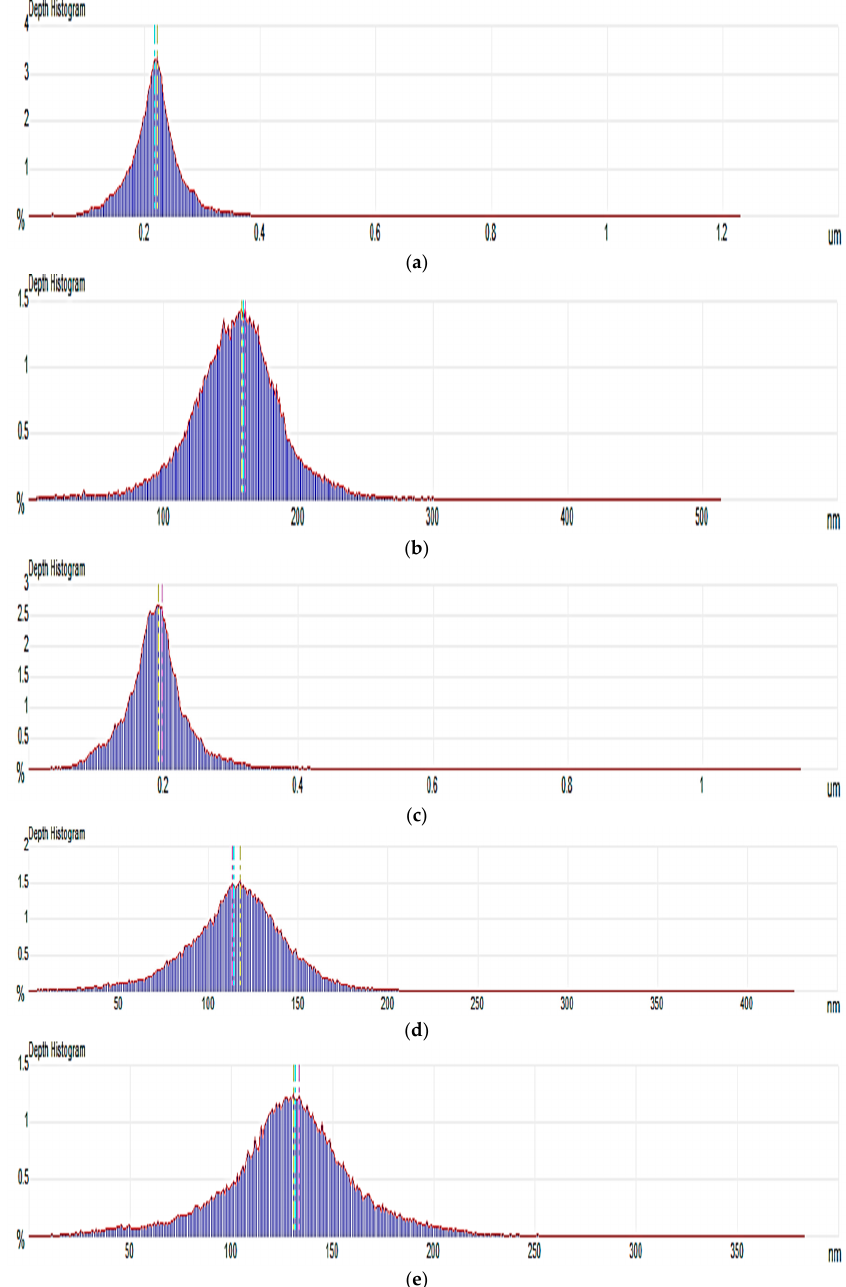
Figure 2. Pore size distributions of: ( a ) PD-neat; ( b ) PDNC-I; ( c ) PDNC-II; ( d ) PDNW-I; and ( e ) PDNW-II membranes.